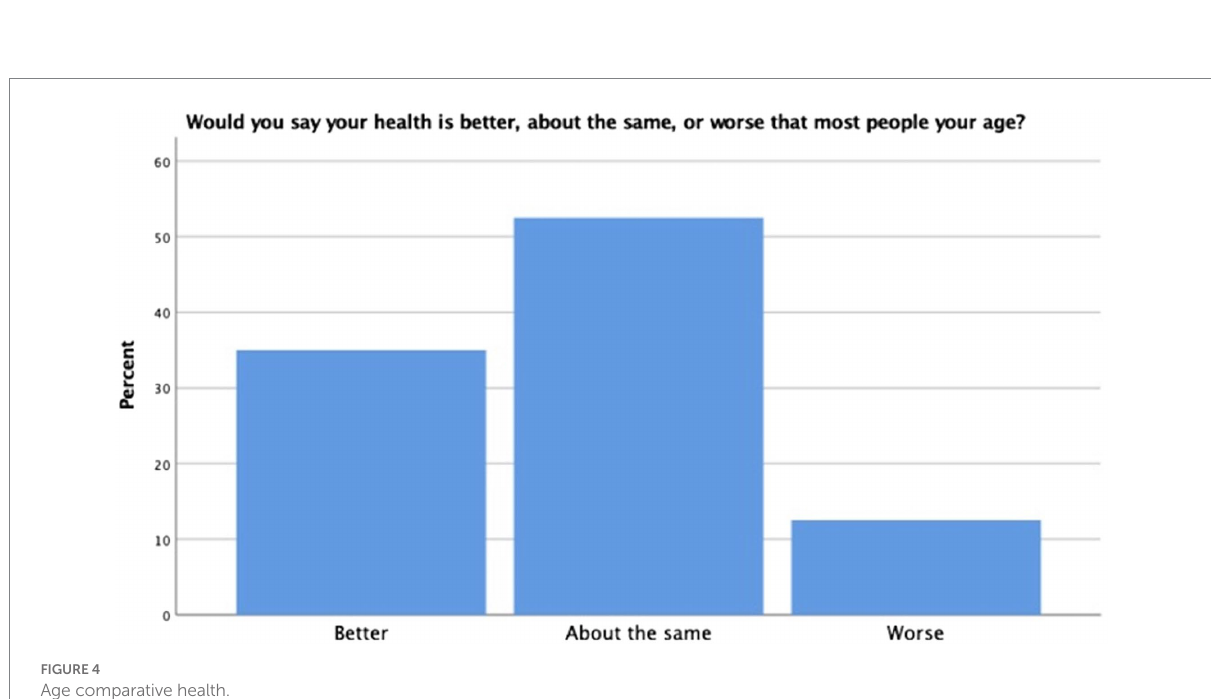
FIGURE 3 Global self-reported health.